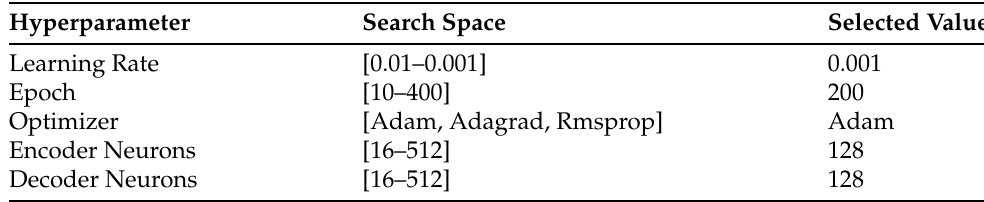
Table 3. Hyperparameter search space and best hyperparameters.